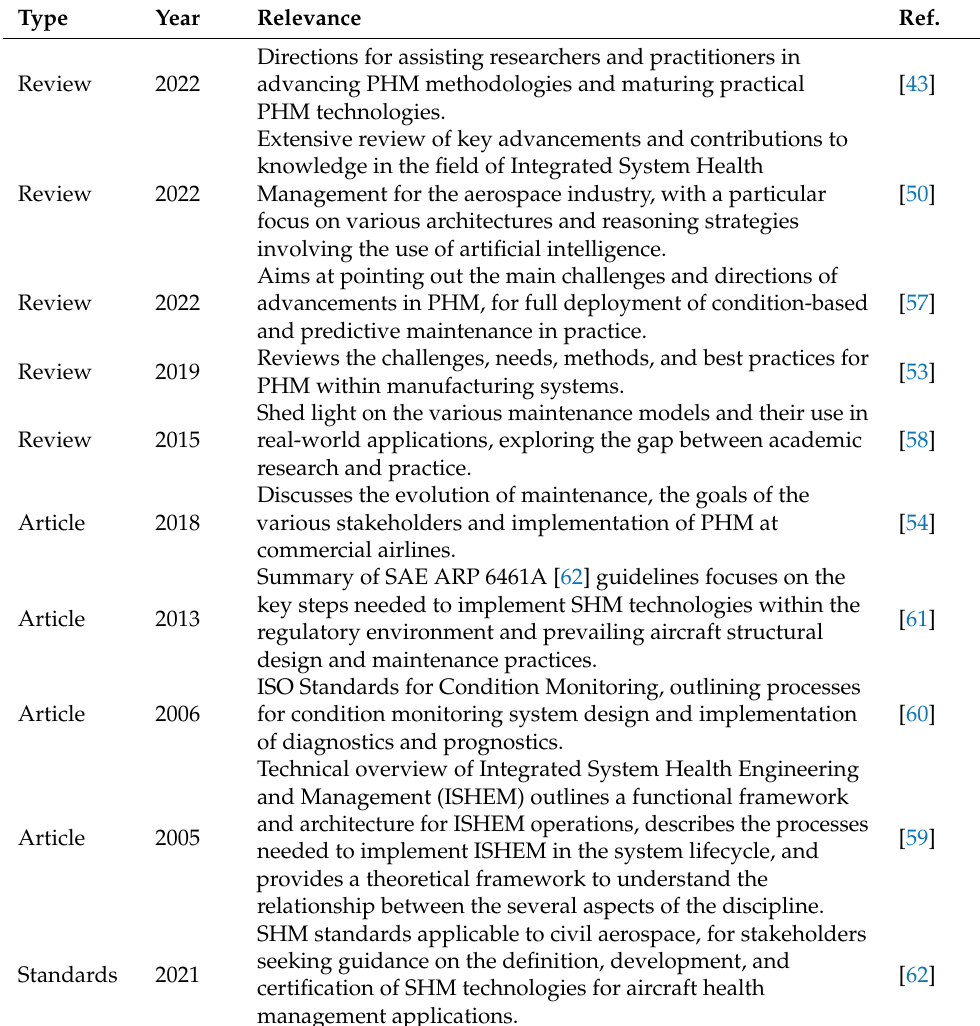
Table 4. Review papers, articles, and standards relevant to predictive